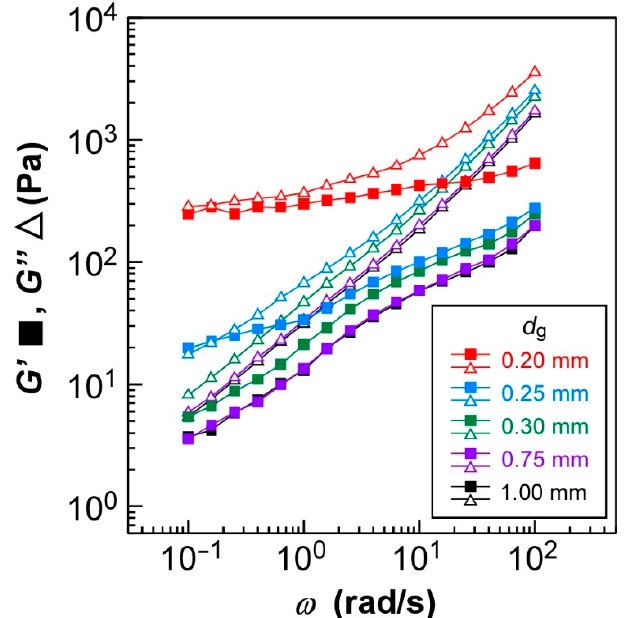
Figure 4. Effect of gap distance ( d g ) of HPC-Pr on its rheological properties. Changes in the storage modulus ( G ’, closed squares) and loss modulus ( G ”, open triangles) of HPC-Pr as a function of angular frequency ( ω ). The rheological measurements were performed at 100 °C, where a reflection peak of CLC phase appeared at 405 nm (Figure 3), and the d g values were adjusted to 0.20 (red symbols), 0.25 (blue symbols), 0.30 (green symbols), 0.75 (purple symbols), and 1.00 mm (black symbols). Notice that the profiles of G ’ and G ” were almost overlapped at the d g values of 0.75 and 1.00 mm.